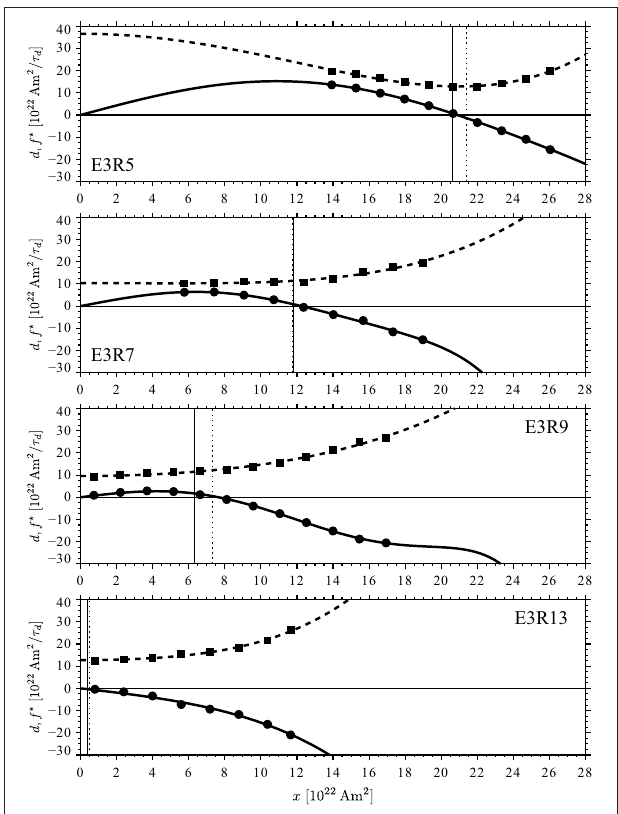
FIGURE 3 | Drift d (circles) and rescaled fluctuation f ⋆ (squares) as function of the axial dipole moment x for the four dynamo models at Ekman number E = 10 − 3 . The curves are the respective low order polynomial fits based on Equations (25) and (26). The solid and dotted vertical lines mark, respectively, the mean and the mode of the (signed) unsigned axial dipole moment distribution in the (multipolar) stable dipolar and reversing